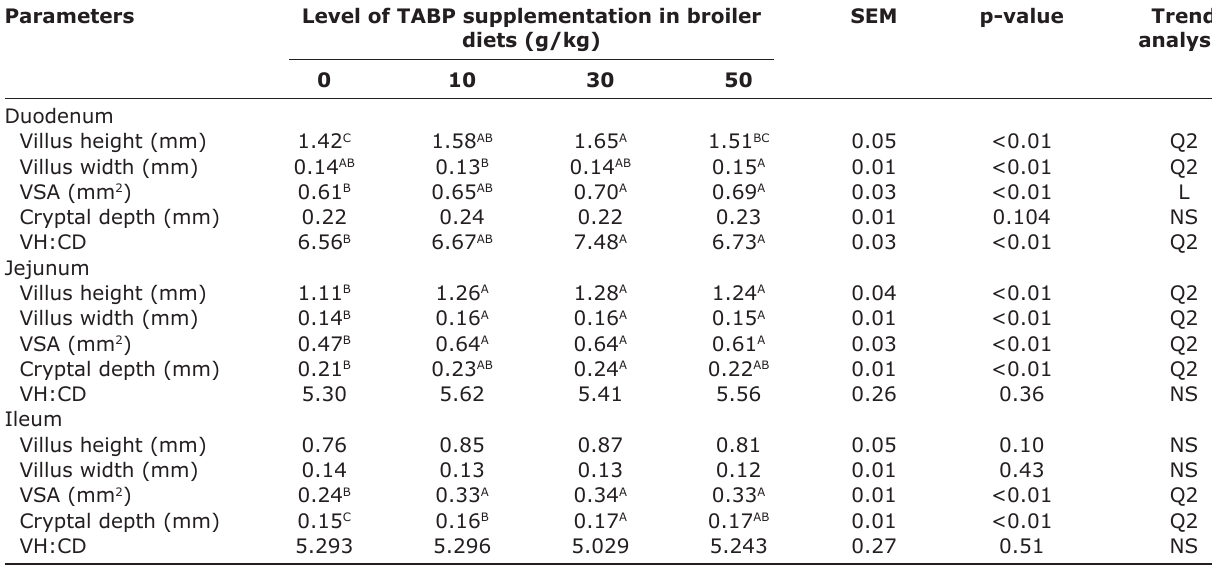
TABP=Trimmed asparagus by-products Table-5: Effects of TABP supplementation in broiler diets on small intestinal histomorphology.